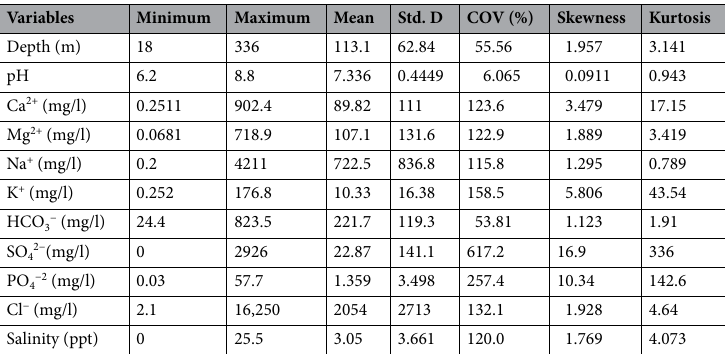
Variables Minimum Maximum Mean Std. D COV (%) Skewness